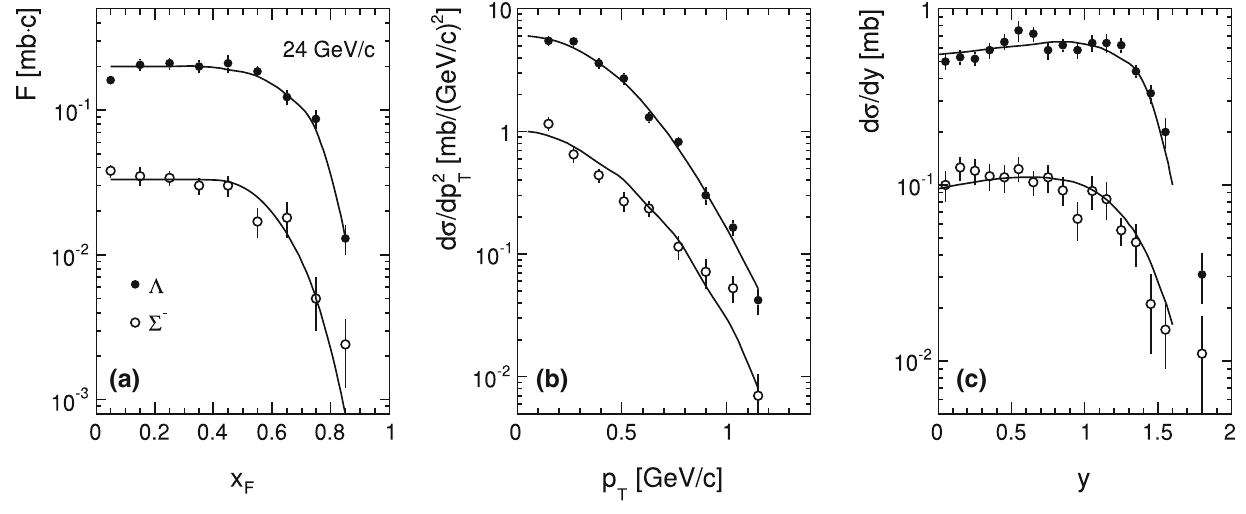
( p ) and c d σ/ dy ( y ) for Σ − as compared to T T